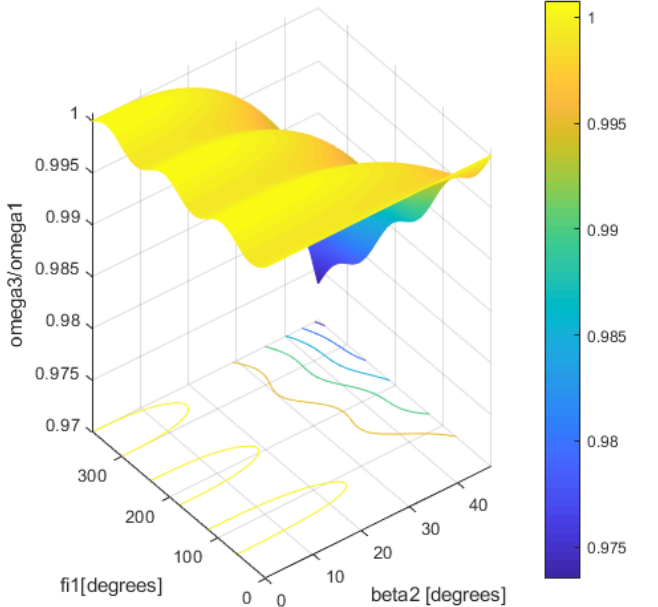
Figure 13. Kinematic nonuniformity of isometry for automotive driveshaft for r 1 /l = 0.11, r 2 /l = 0.09, β 2 = 47°.